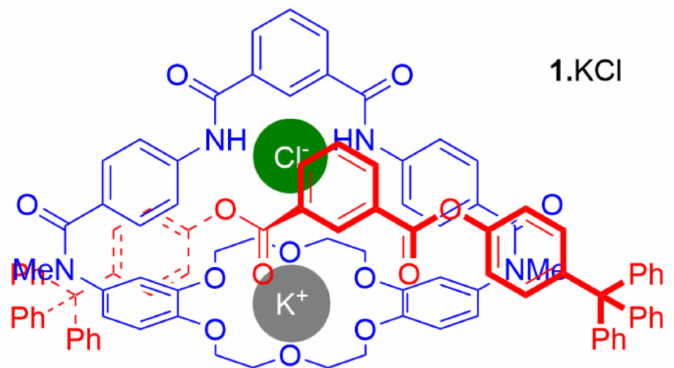
Figure 2. Proposed binding mode of KCl by Smith’s original rotaxane 1